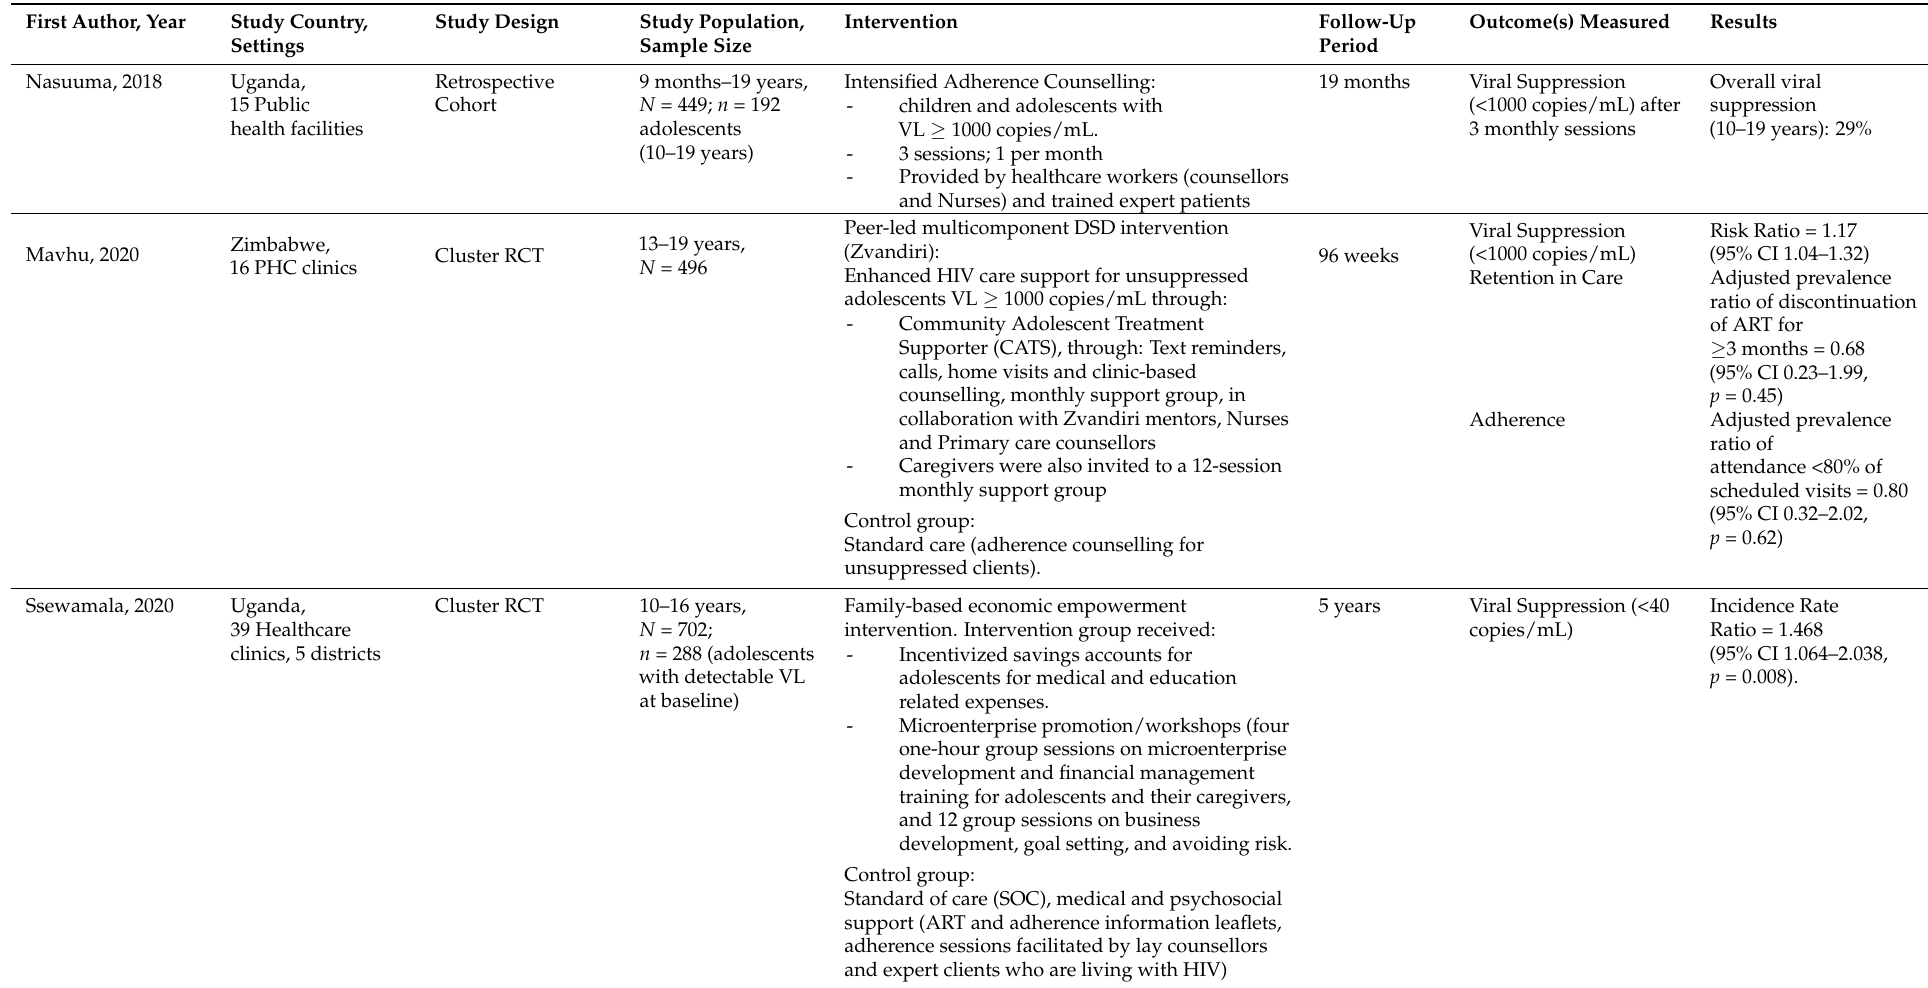
Table 1. Summary characteristics of included studies of